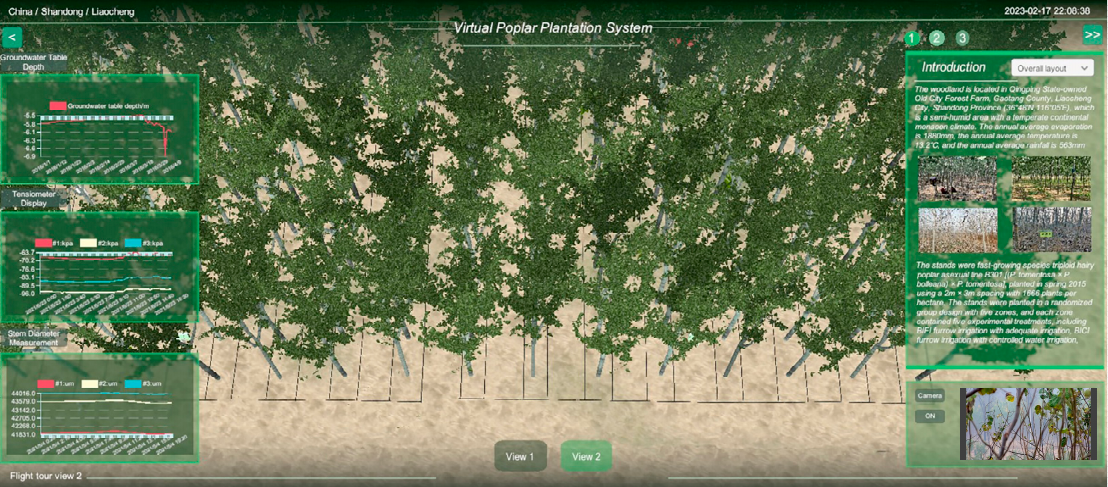
Figure 11. Virtual poplar plantation system’s main interface display. The left and right sides are the task bars for the corresponding functions.